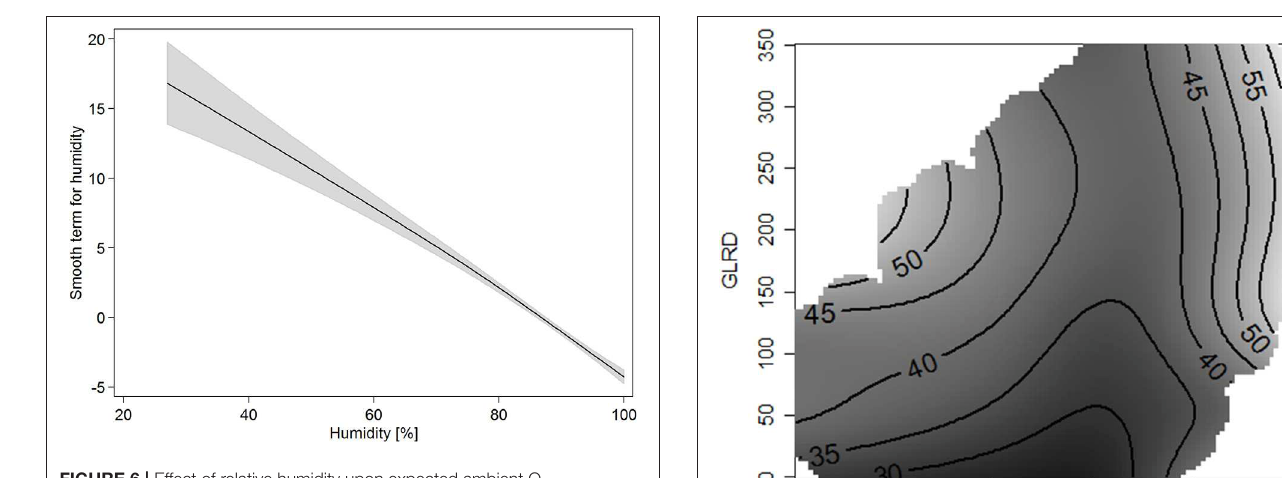
FIGURE 6 | Effect of relative humidity upon expected ambient O 3 concentration, BKR site.